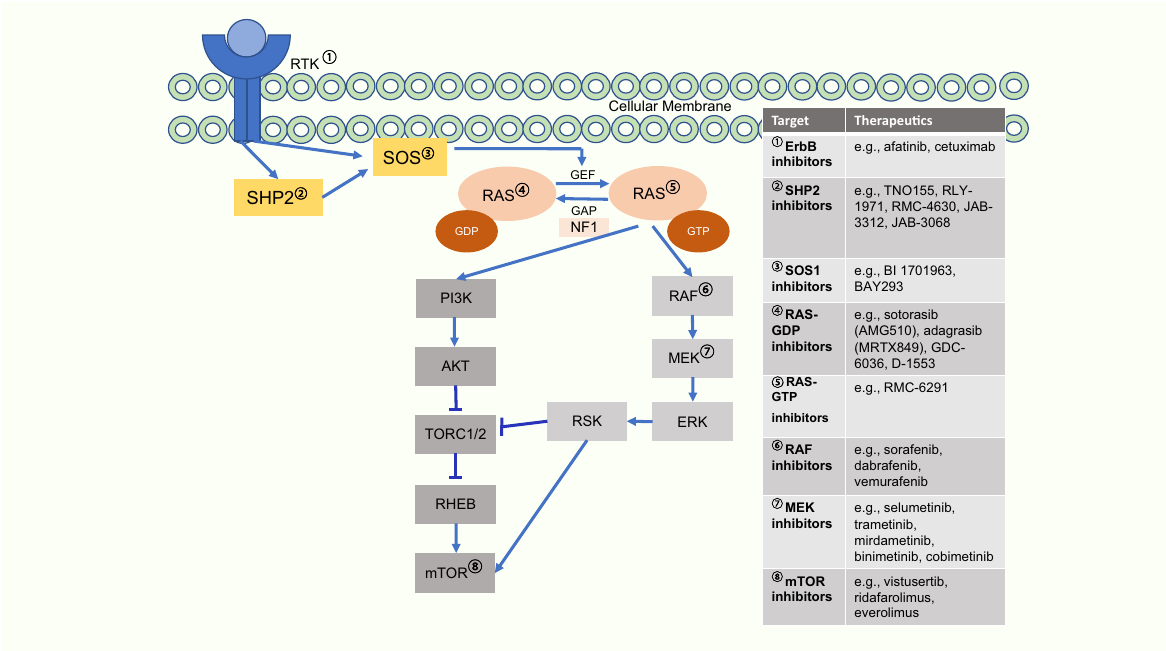
Fig. 1 RAS/MAPK pathway downstream signaling and therapeutic targets. RAS/MAPK pathway noting therapeutic targets and some associated therapies currently being